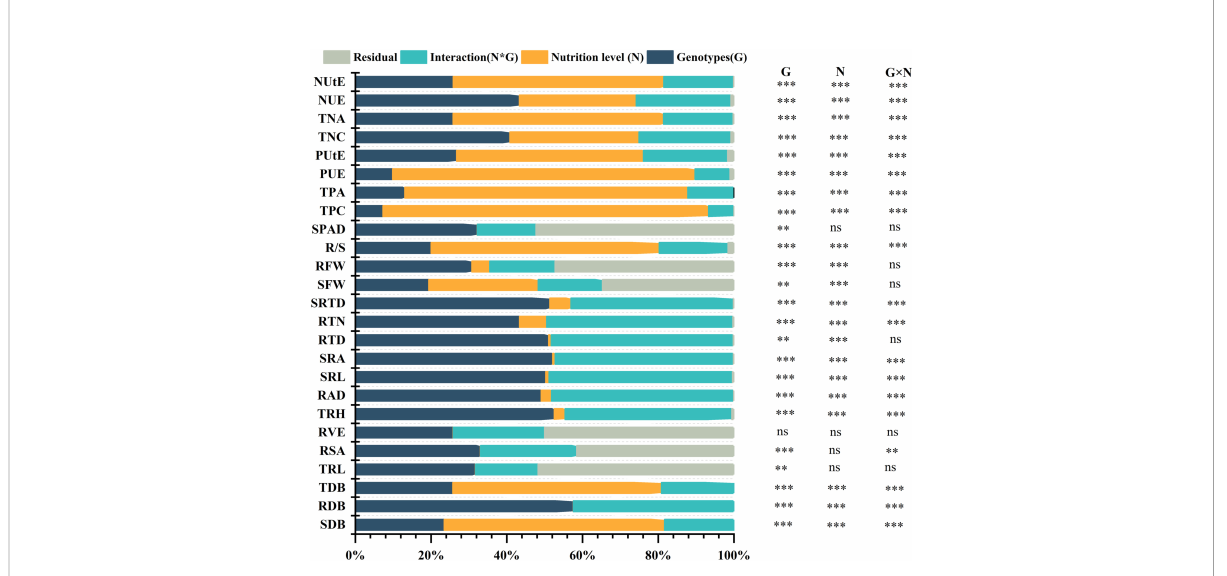
FIGURE 4 Global ANOVA of morphological traits of 384 cotton genotypes in response to different P supplies. The main effects (Genotypes (G) and nutrition level (N), interaction (G×N), and residual (R) represent as a percentage of type III sums of squares. P-values of the F-test are indicated. **: P < 0.01; ***: P < 0.001; ns: not signi fi